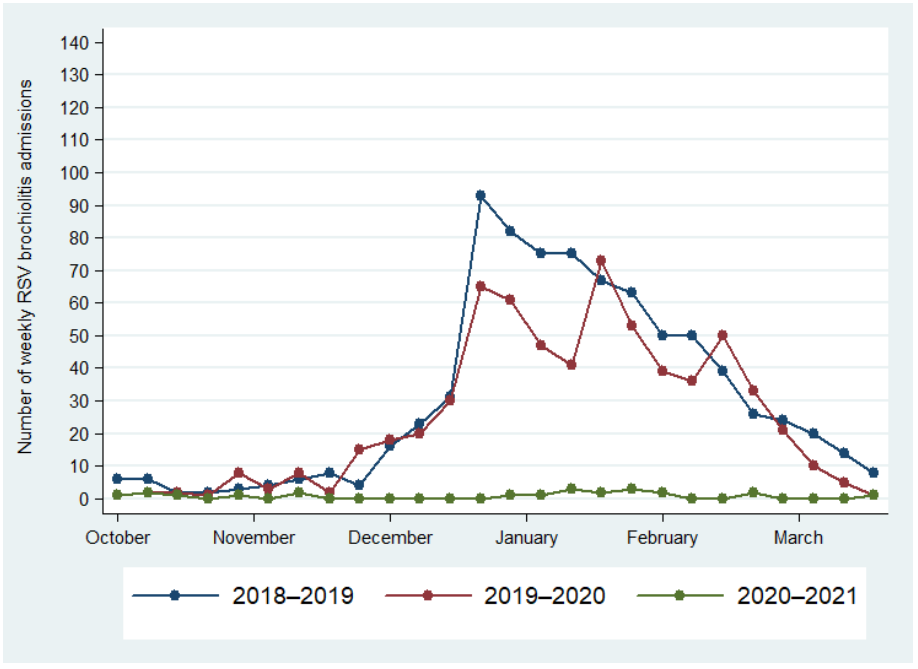
Figure 3. Hospitalization due to RSV infection during the pre-pandemic seasons (2018–2019 and 2019–2020) and during the 2020–2021 year of SARS-CoV-2 pandemic.